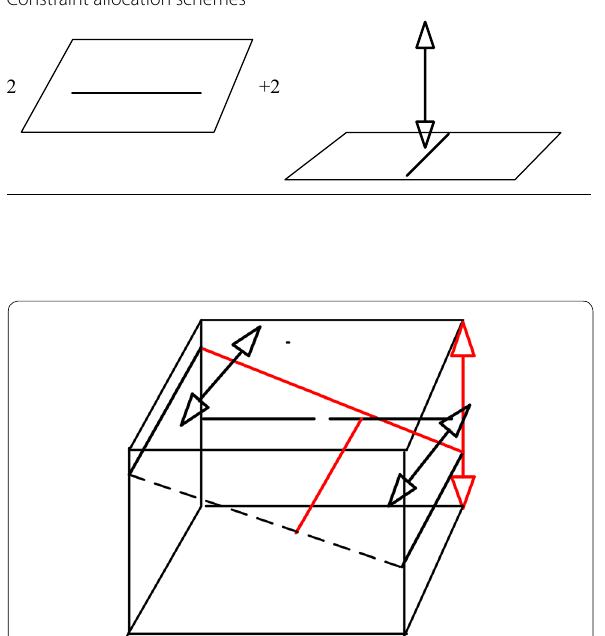
Figure 5 F&C line graph of mobile